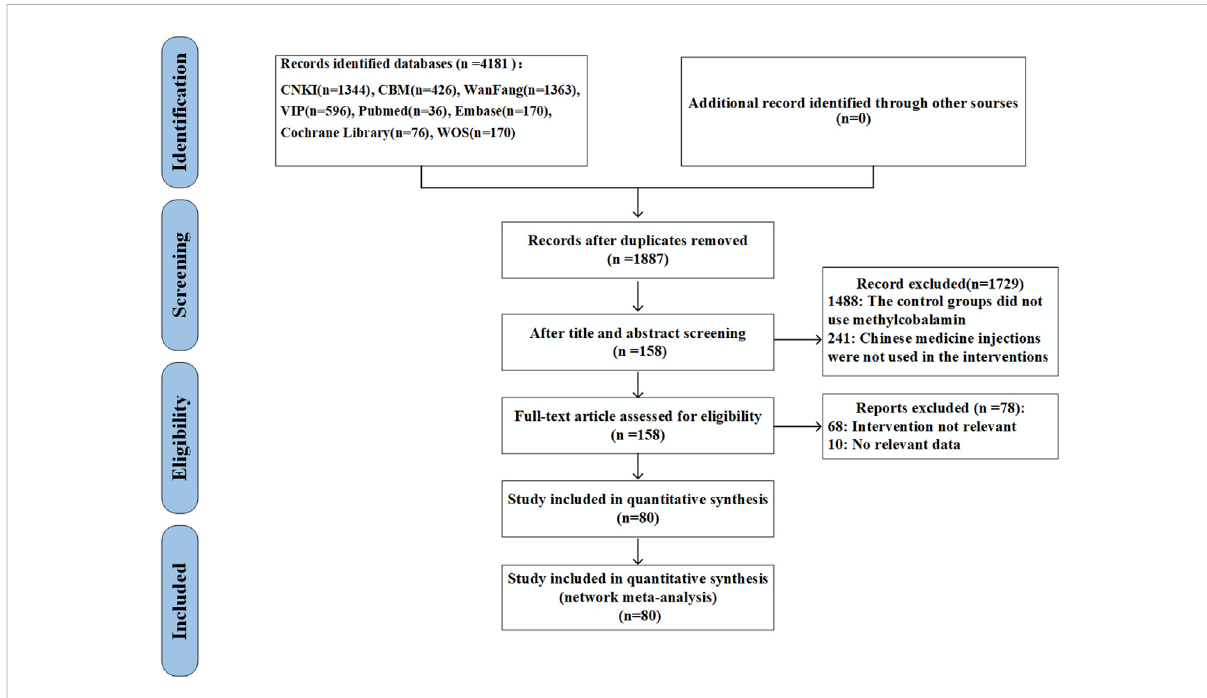
FIGURE 1 Flowchart of searching and screening for the